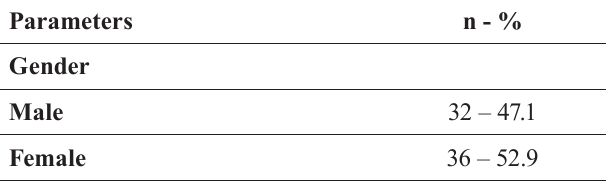
TABLE I - S ociodemographic and clinic data collected at the baseline of the pharmacotherapeutic follow-up, of the studied population Parameters